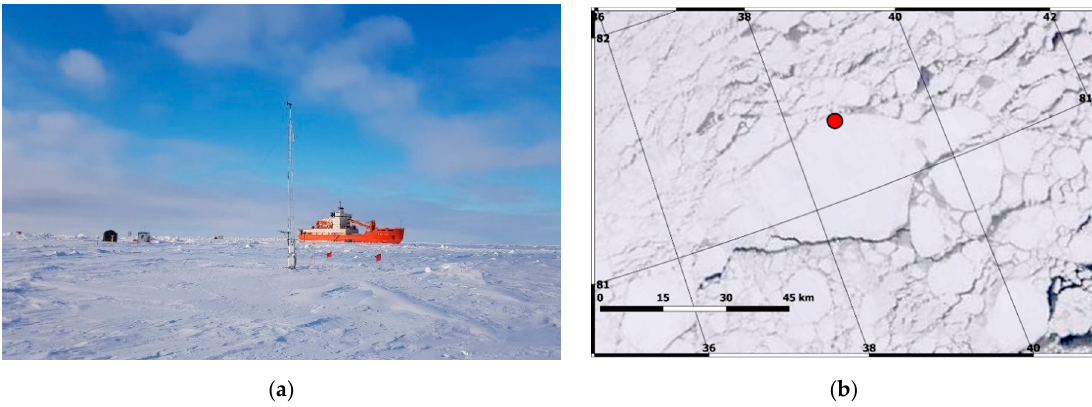
Figure 2. ( a ) Photo of the meteorological tower with “R/V Akademik Tryoshnikov” in the background (photo: V. Kustov). ( b ) Moderate Resolution Imaging Spectroradiometer (MODIS) image (visible channel, 250 m resolution) for 06:00 UTC 11 April 2019. The position of “R/V Akademik Tryoshnikov” is indicated by a circle (image from NASA worldview). Table 1. Meteorological instrumentation during Transarktika in April 2019.